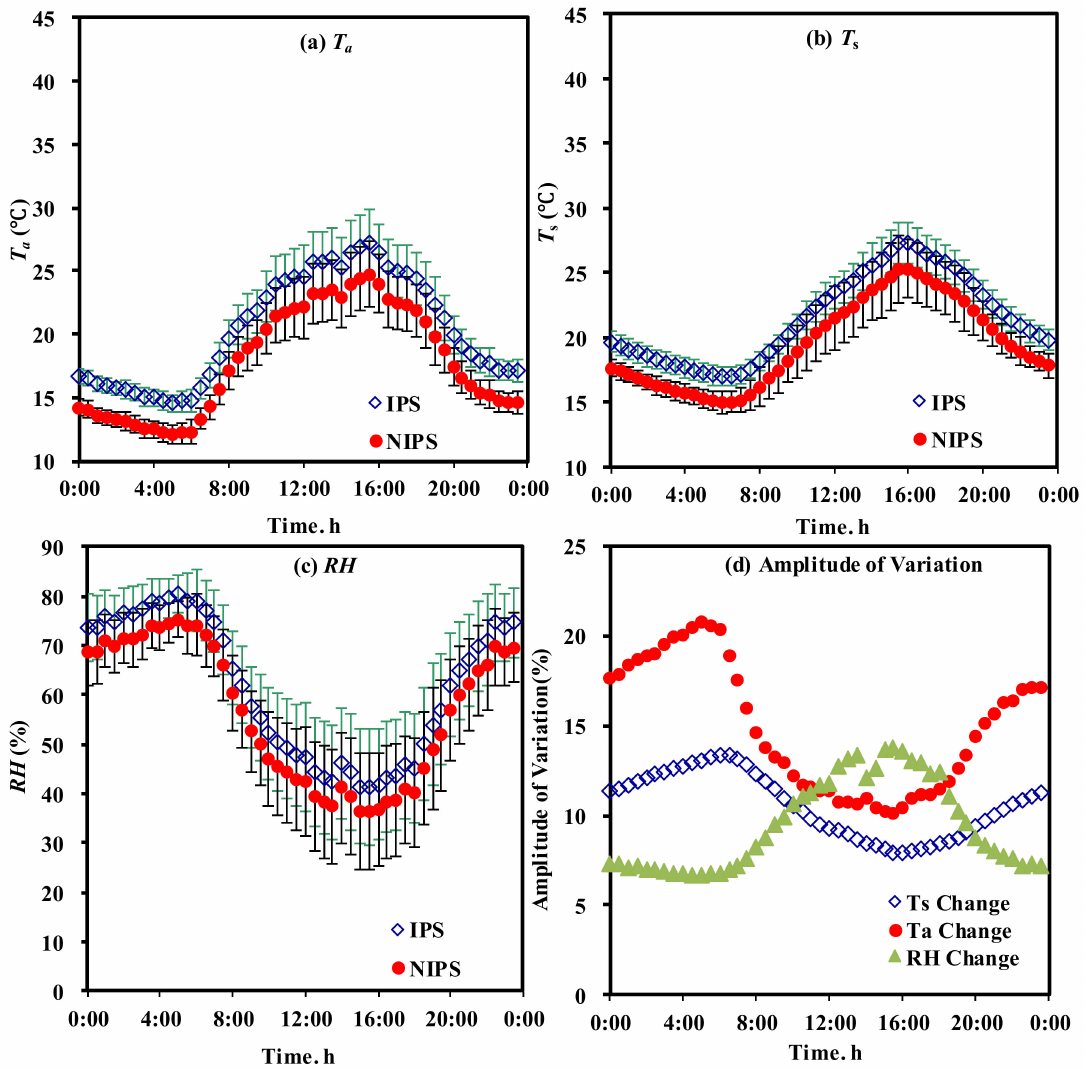
Figure 5. Diurnal courses of ( a ) T a , ( b ) T s , ( c ) RH , and ( d ) amplitude of variation, under the IPS and NIPS treatments during C1. Average over 8 days (1–8 June 2016). The vertical bar represents one standard